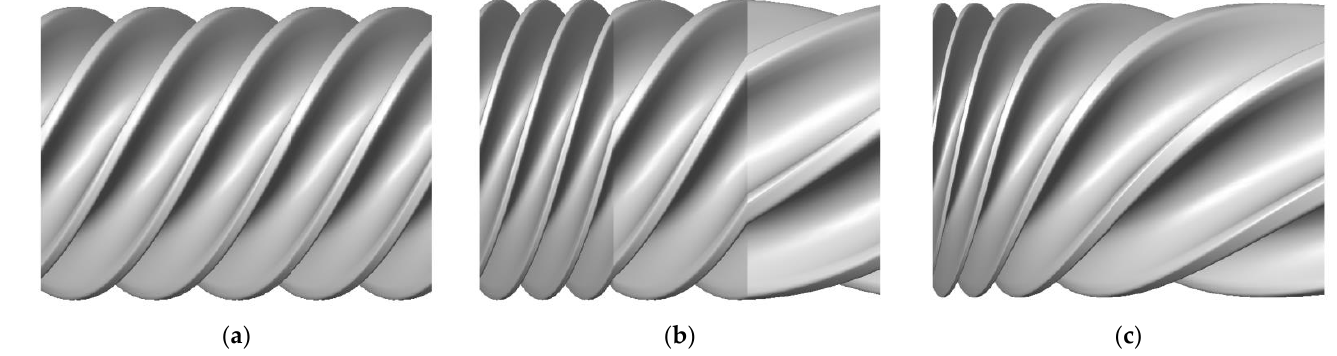
Figure 2. Rotor structure with various lead. ( a ) Constant lead ( b ) Multiple (triple) lead ( c ) Continu- ously variable